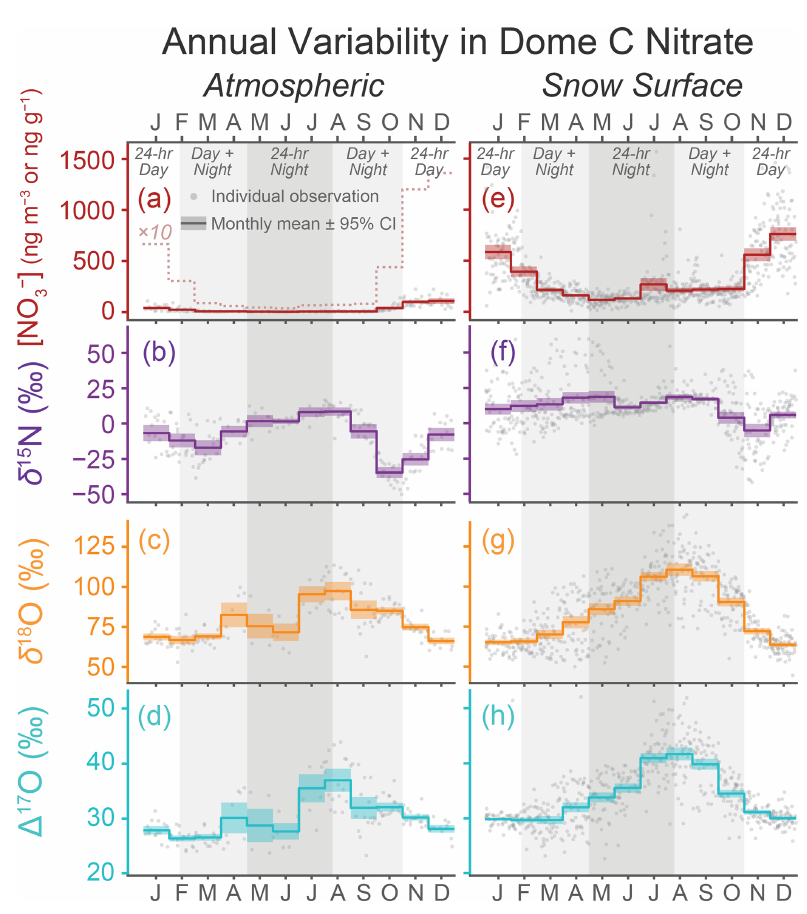
− variability in the atmospheric and snow surface at Concordia station, Dome C, Antarctica. Data shown Figure 1. Annual patterns of NO 3 (a–d) was collected cover previously reported samples taken in 2009–2014 (Erbland et al., 2013; Winton et al., 2020). Atmospheric NO − 3 over week-long periods with a high-volume air filter located 5m above the snow surface and snow surface samples (e–h) were taken every 1–7d from the 2–6mm thick skin layer in the clean sector outside Concordia station. Individual points represent individual samples and the thick colored lines represent the monthly mean values with the 95% confidence interval of the mean shown as colored shading. Note that the (a) and ngg − 1 for the snow surface NO − (e) . A dashed line representing the units for NO − concentration is ngm − 3 for atmospheric NO − 3 3 3 atmospheric NO − concentration multiplied by 10 is included in (a) for better observation of the annual variation 3